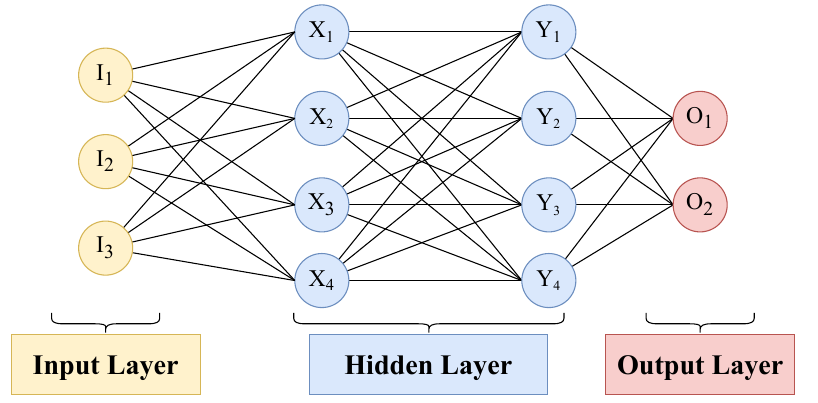
Figure 3. Schematic of an MLP model.